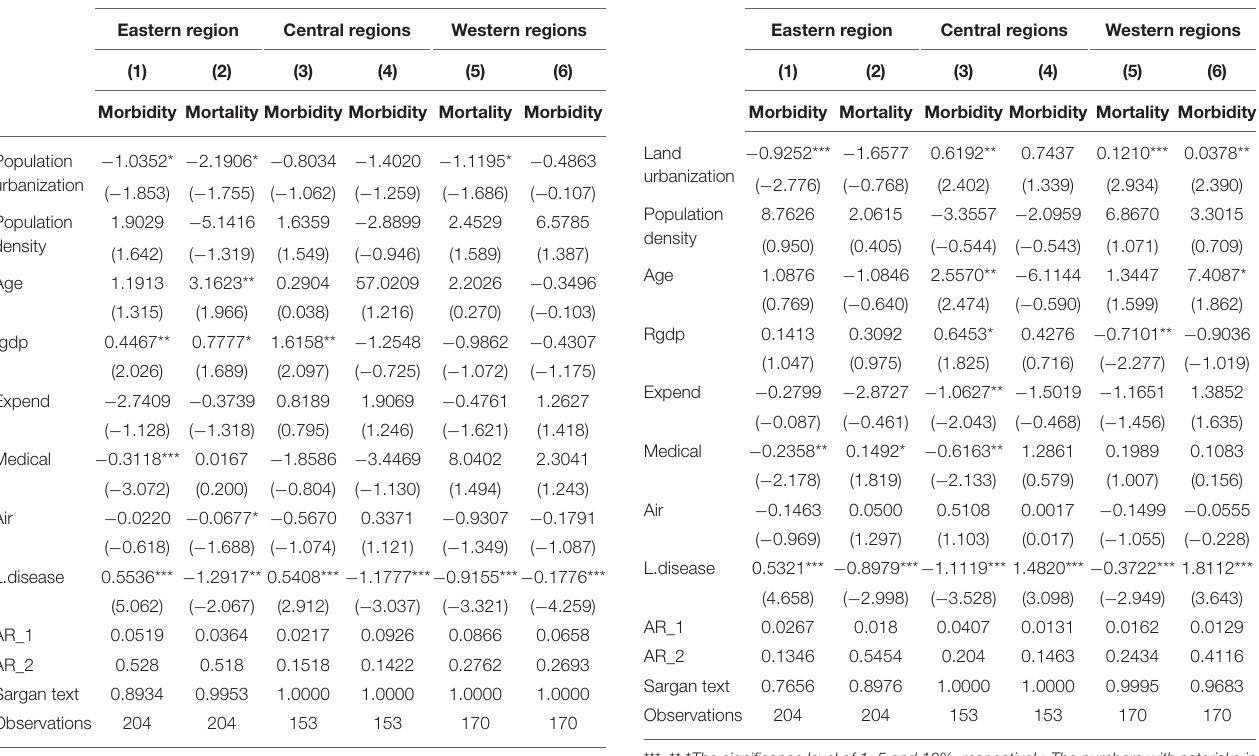
TABLE 6 | The robustness test of land urbanization. Variables DIFF-GMM Eastern region Central regions Western